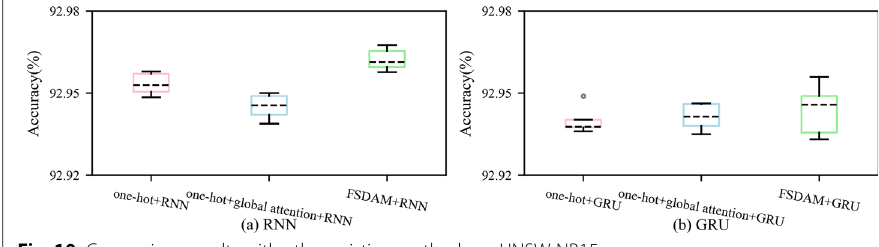
Fig. 10 Comparison results with other existing methods on